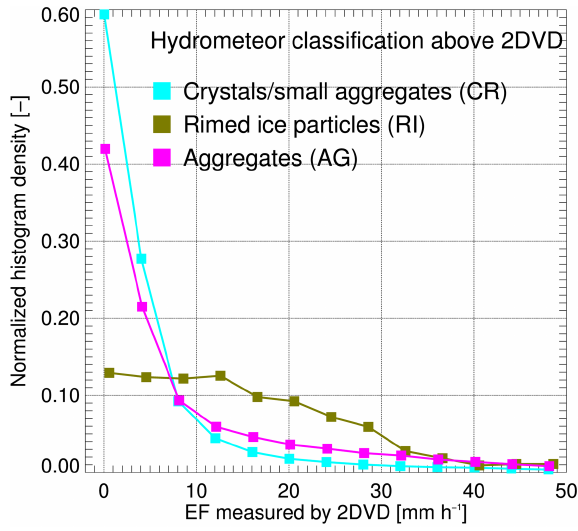
Figure 9. Sampled probability density function of snowfall inten- sity, as quantified by the equivalent flux EF [mmh − 1 ], measured by the 2DVD and associated with the radar hydrometeor classification output above the location of the 2DVD. The data used in this figure were collected during the field deployment of Davos (CH).